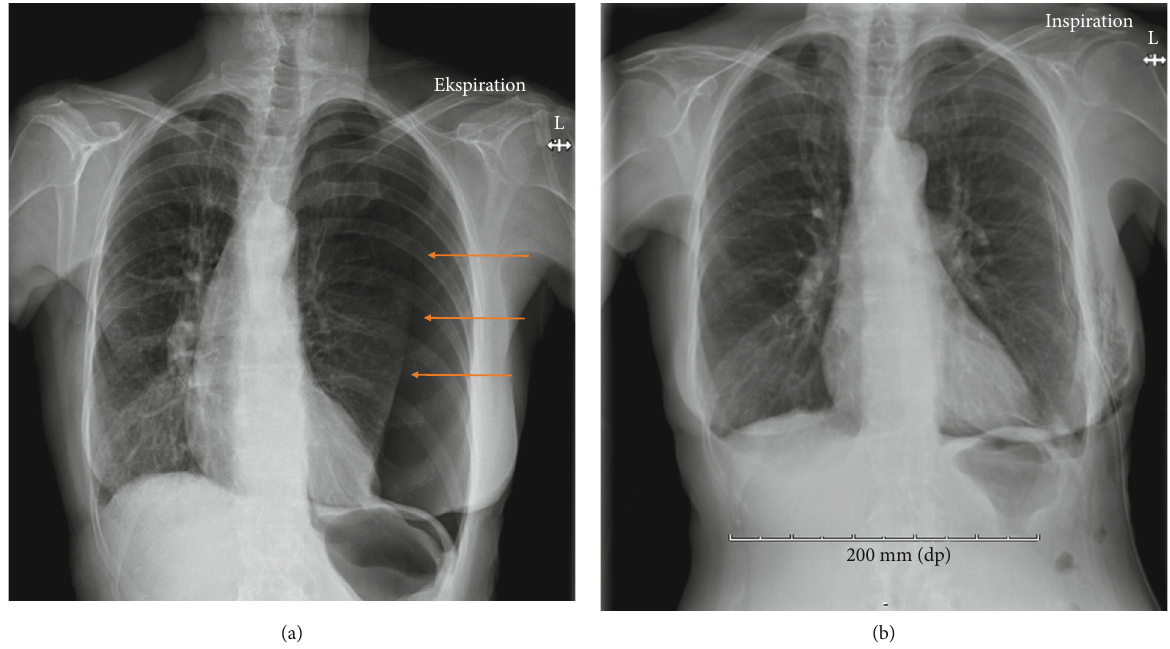
Figure 2: (a) Chest X-ray showing tension pneumothorax of the left lung. The fi rst chest X-ray showed a large left-sided rim pneumothorax, extending along the entire lateral border of the lung, from the base to the apex, and with a maximal width of 6 cm at the base of the left lung. (b) Chest X-ray showing subcutaneous emphysema. A postintervention chest X-ray showed an intercostal drain placed at about the 8th intercostal space on the left side. A near complete regression of the pneumothorax is seen, with the lung parenchyma again extending to the borders the left hemithorax and a smaller residual rim apicolaterally measuring 12 mm. In the soft tissues at the puncture point, multiple di ff use hypodense areas are seen, resembling subcutaneous